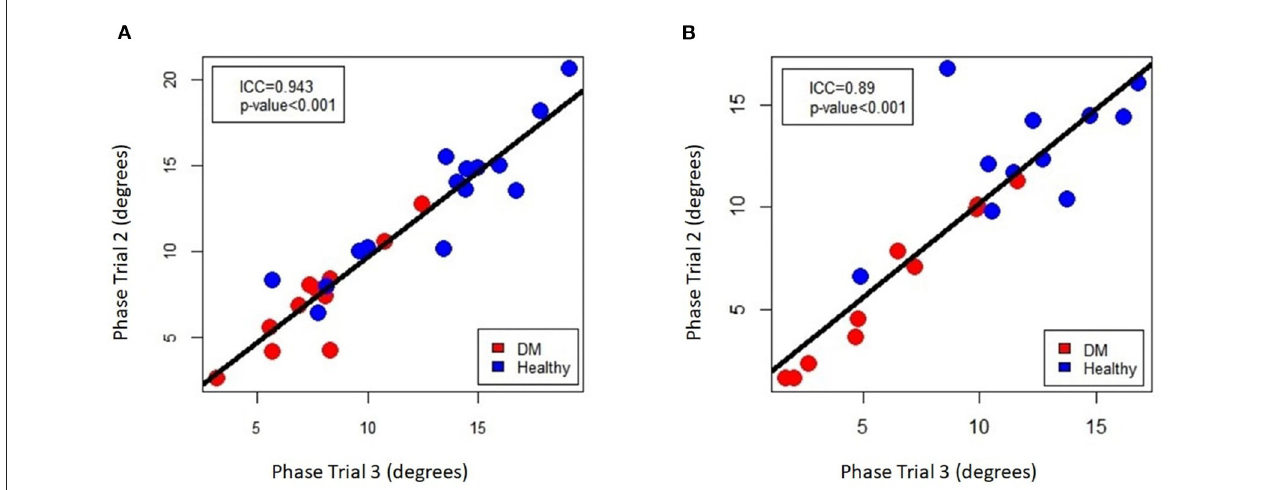
FIGURE 6 | Intra-class correlation coefficient plot of EIM phase measurements for repeated sampling of the (A) left and (B) right gastrocnemius muscle, comparing the 2nd and 3rd of the three data acquisitions that were performed on each